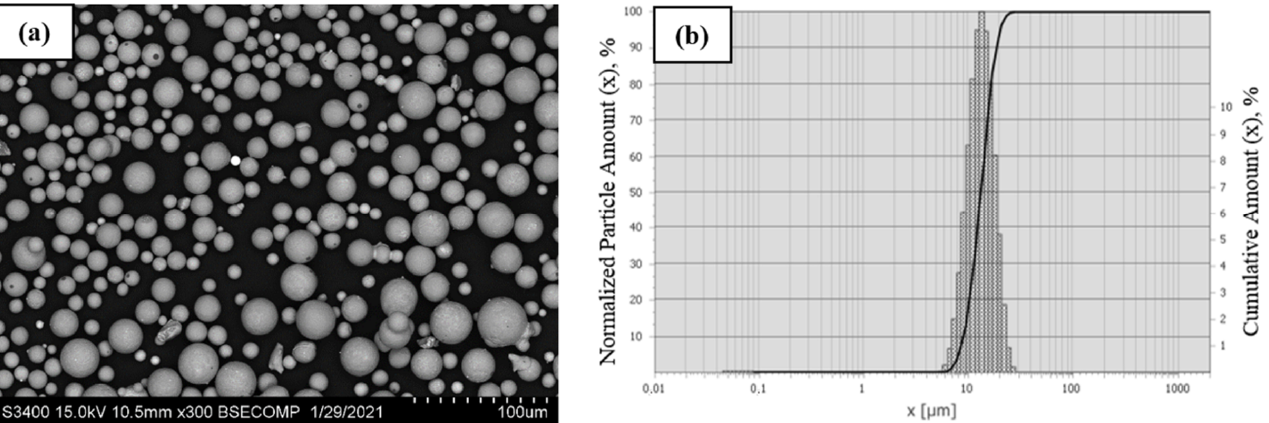
Figure 21. The morphology ( a ) and granulometric composition ( b ) of the NiAl-Cr-Co+15%Mo alloy powder at I pl = 1.9 kW h/m 3 , G powder = 3 kg/h, with Ar + H 2 used as a plasma supporting gas.